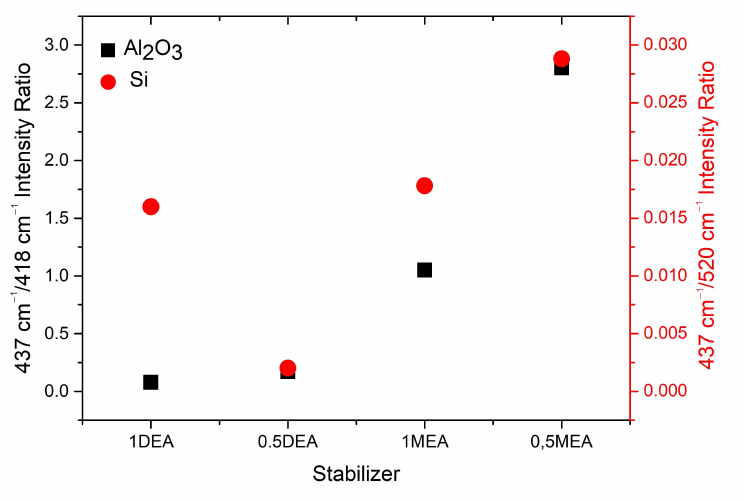
Figure 10. Ratio of intensities of ZnO E 2 (high) mode to the most prominent peak of substrate for sapphire (black) and silicon